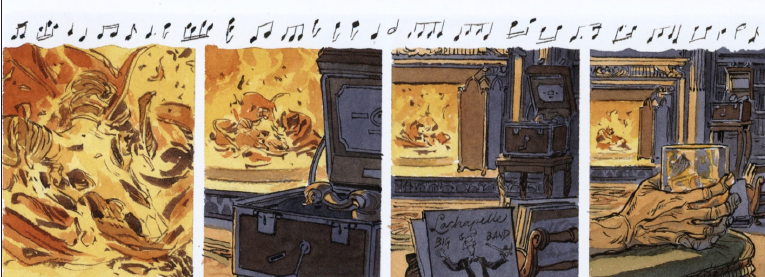
Figure 5: Juan Diaz Canales and Juanjo Guarnido, Blacksad: A Silent Hell , 2012, Dark Horse Books, p.